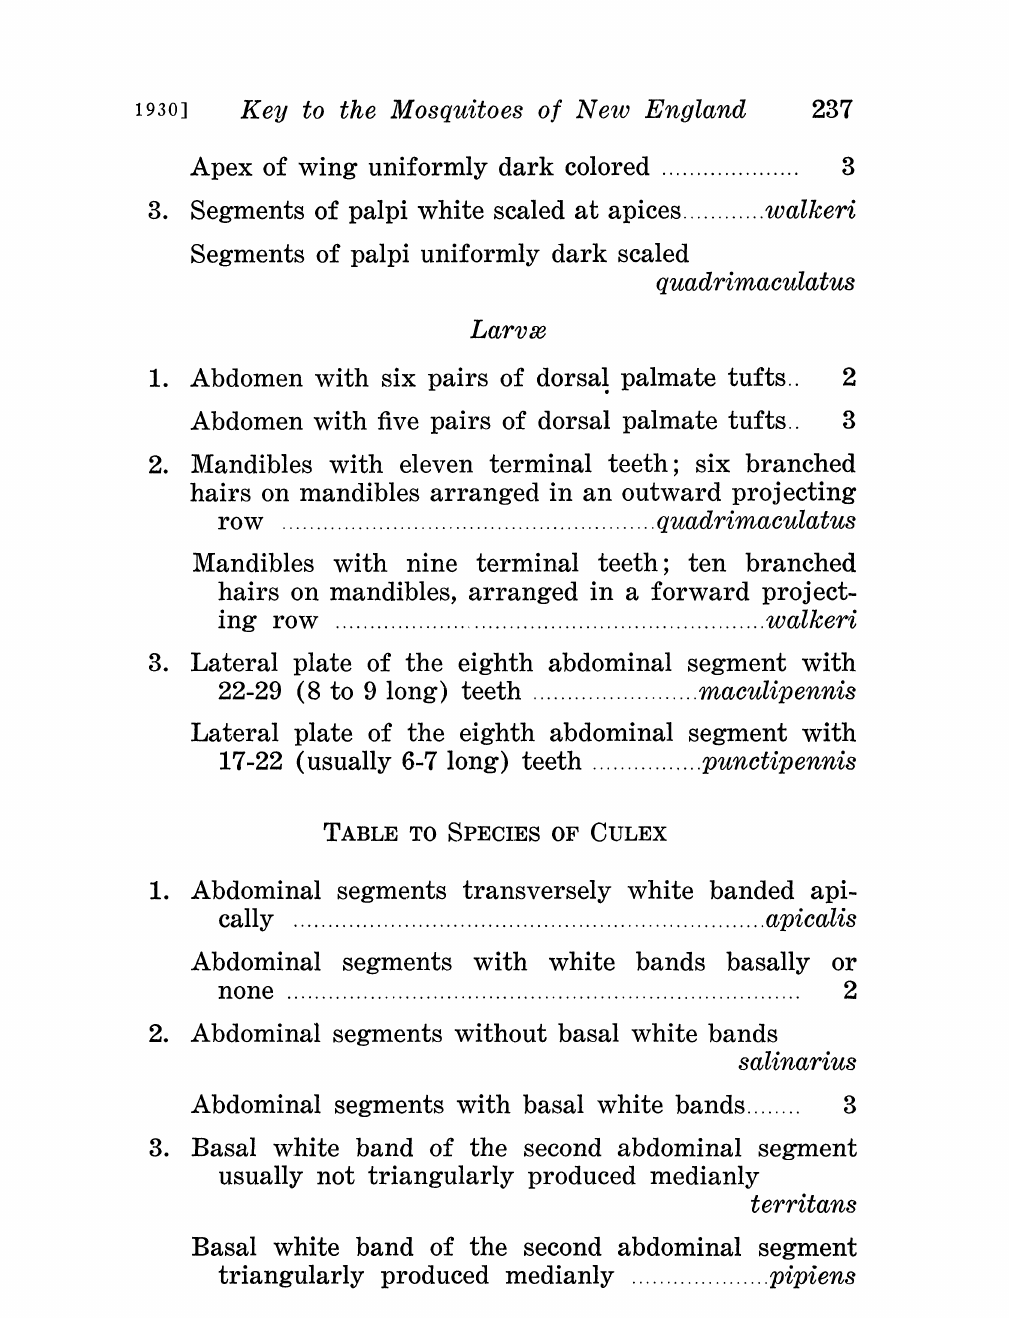
1. Abdominal segments transversely white banded api- cally apicalis Abdominal segments with white bands basally or none 2. Abdominal segments without basal white bands